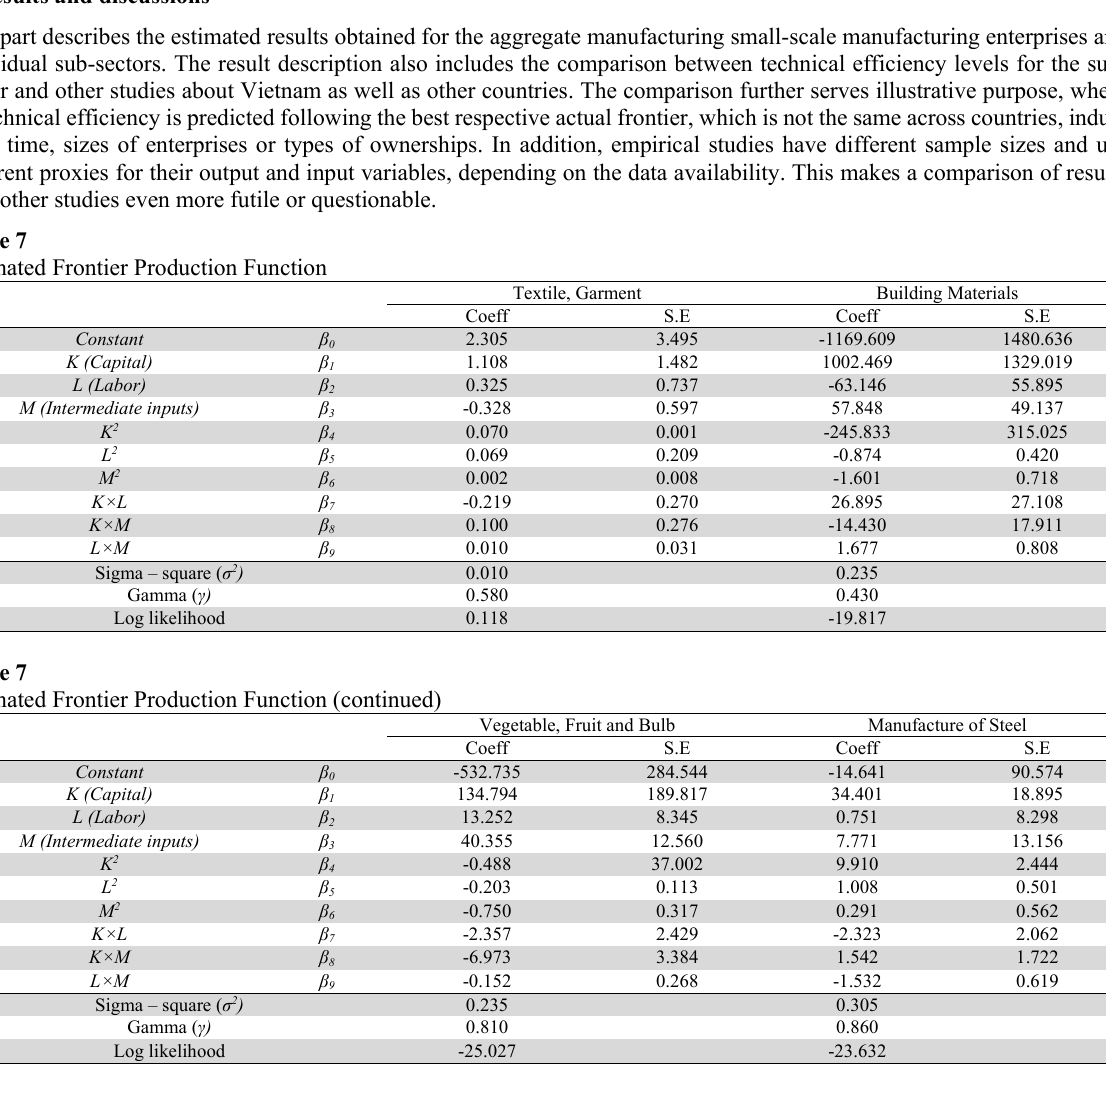
Estimated Frontier Production Function